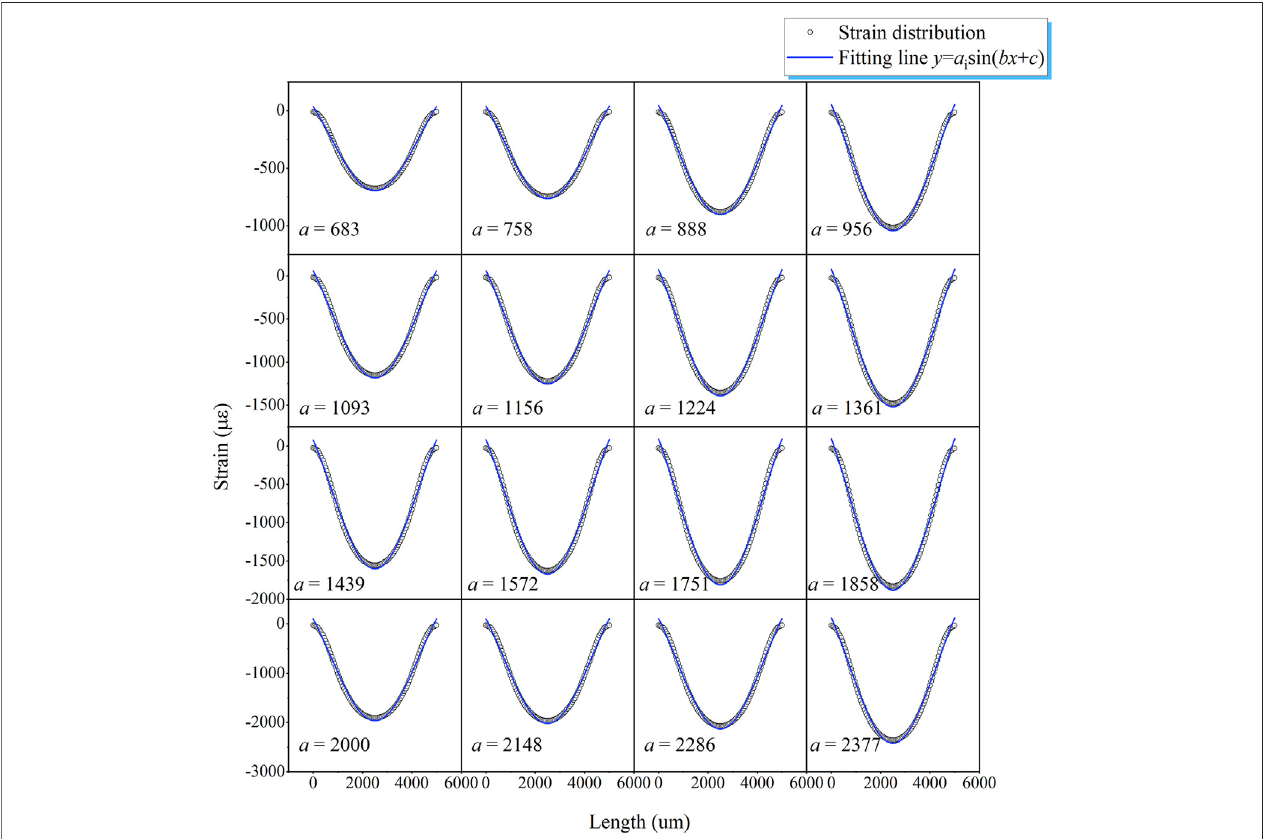
FIGURE 5 | Fitting curve of the large-gradient nonuniform strain distributions in glass-to-metal with gradient parameters a .